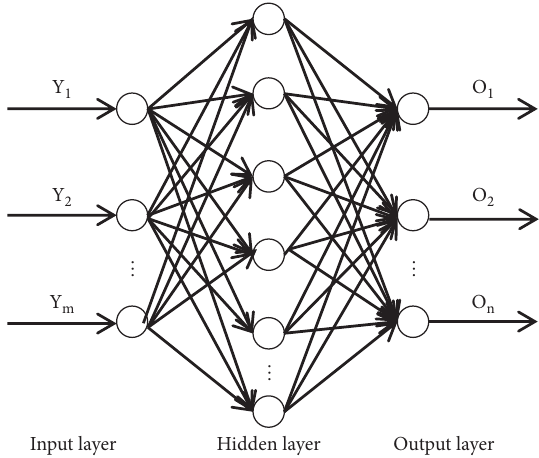
Figure 2: Topology structure of BP neural